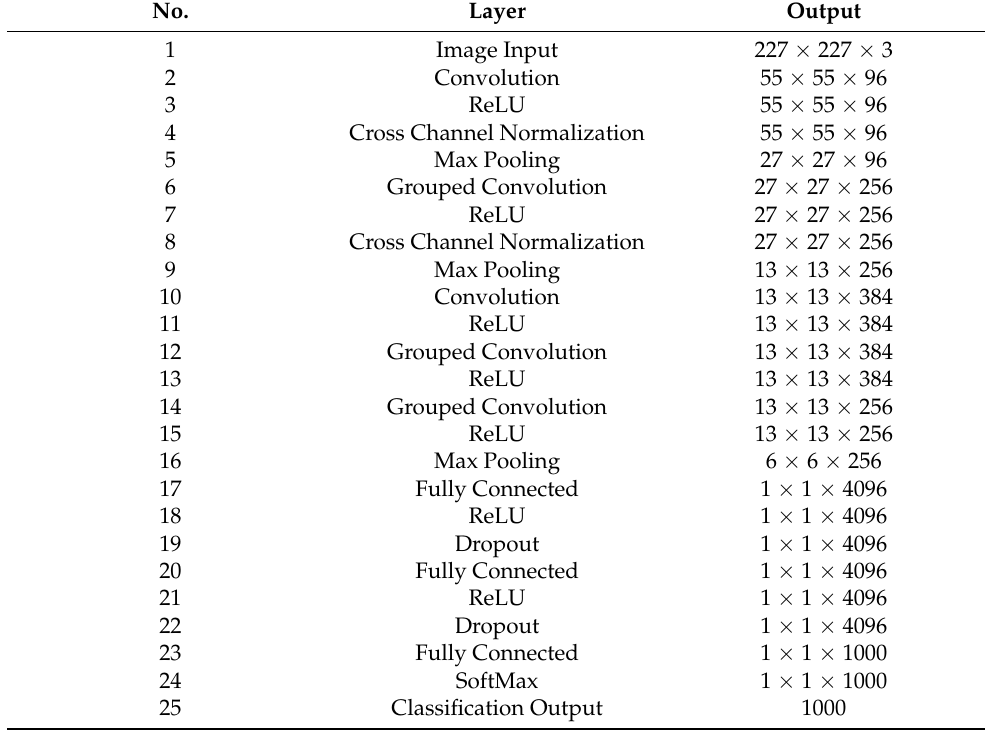
Table 3. Network architecture of